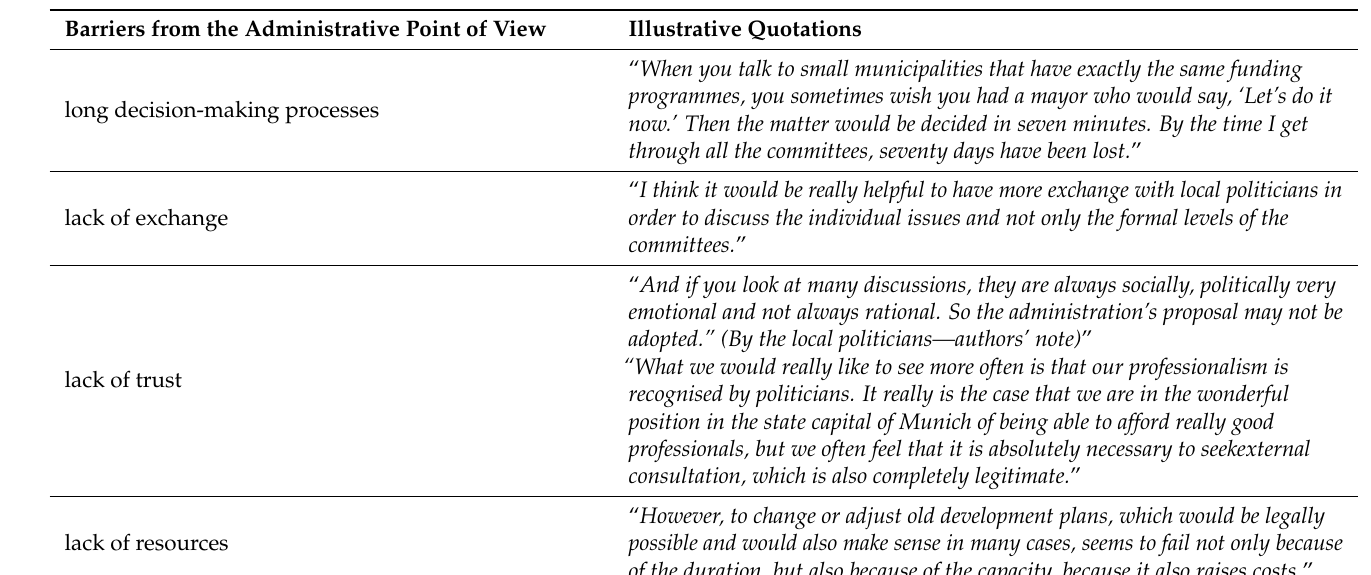
Table 5. Barriers linked to collaborative arrangements between administration and political